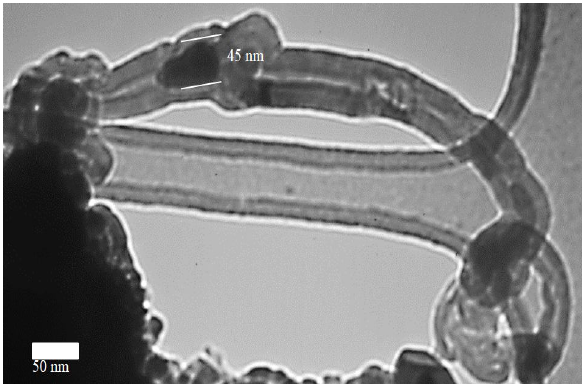
TEM images of Zn NT is typically given in 0.05 950 Figure 6. The observation of hollow tube with an outer diameter about 50 nm confirmed that carbon nanotubes were synthesized out of the other carbon forms. Also, the small dark particle with diameter NT , (b) Zn NT , (c) 4 950 2 950 about 45 nm inside the carbon nanotubes has almost the same diameter of some synthesized CNTs.